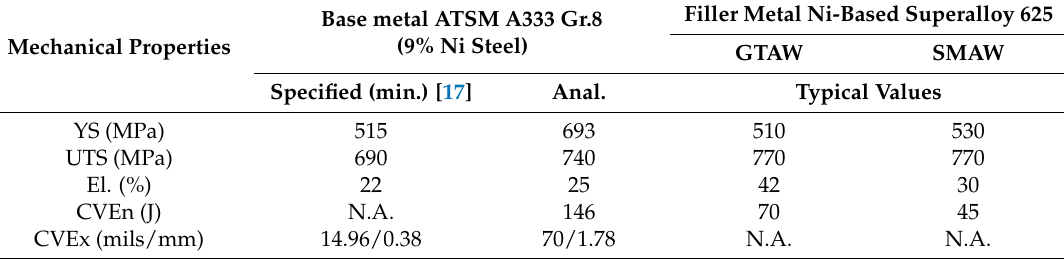
Table 1. Specified and analyzed mechanical properties-yield strength (YS), ultimate tensile strength (UTS), elongation (El.) and Charpy V energy at − 196 ◦ C (CVEn) and lateral expansion (CVEx)-of the base metal and typical values of filler metals mechanical